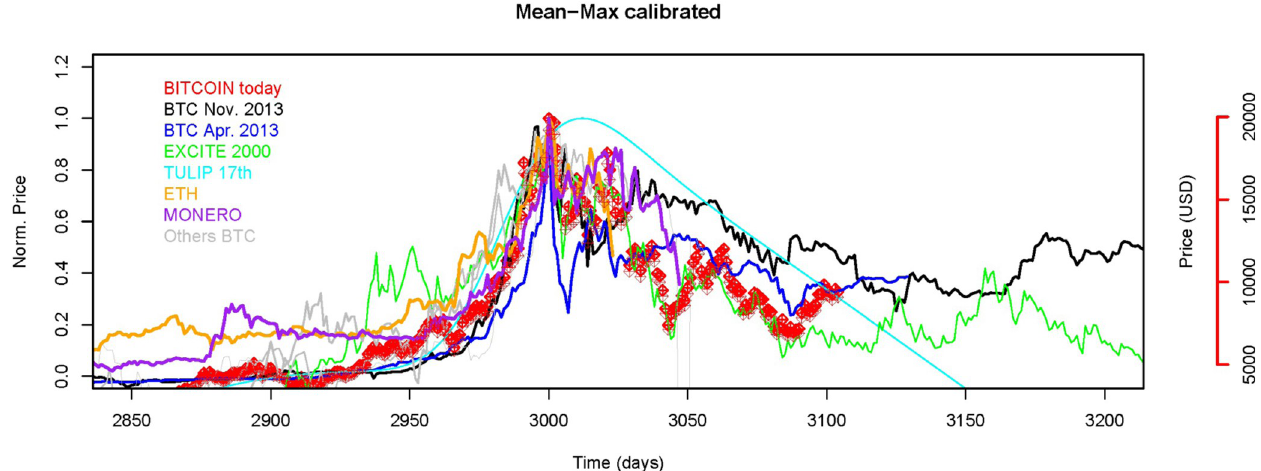
Fig 7. Time-shifted (x-axis) and normalized (y-axis) time-series corresponding to data shown in Fig 1. We compare BTC price to BTC pricing periods, Excite stock price, Tulip bulb crisis, and ETH/MONERO prices observed in 2017–2018.